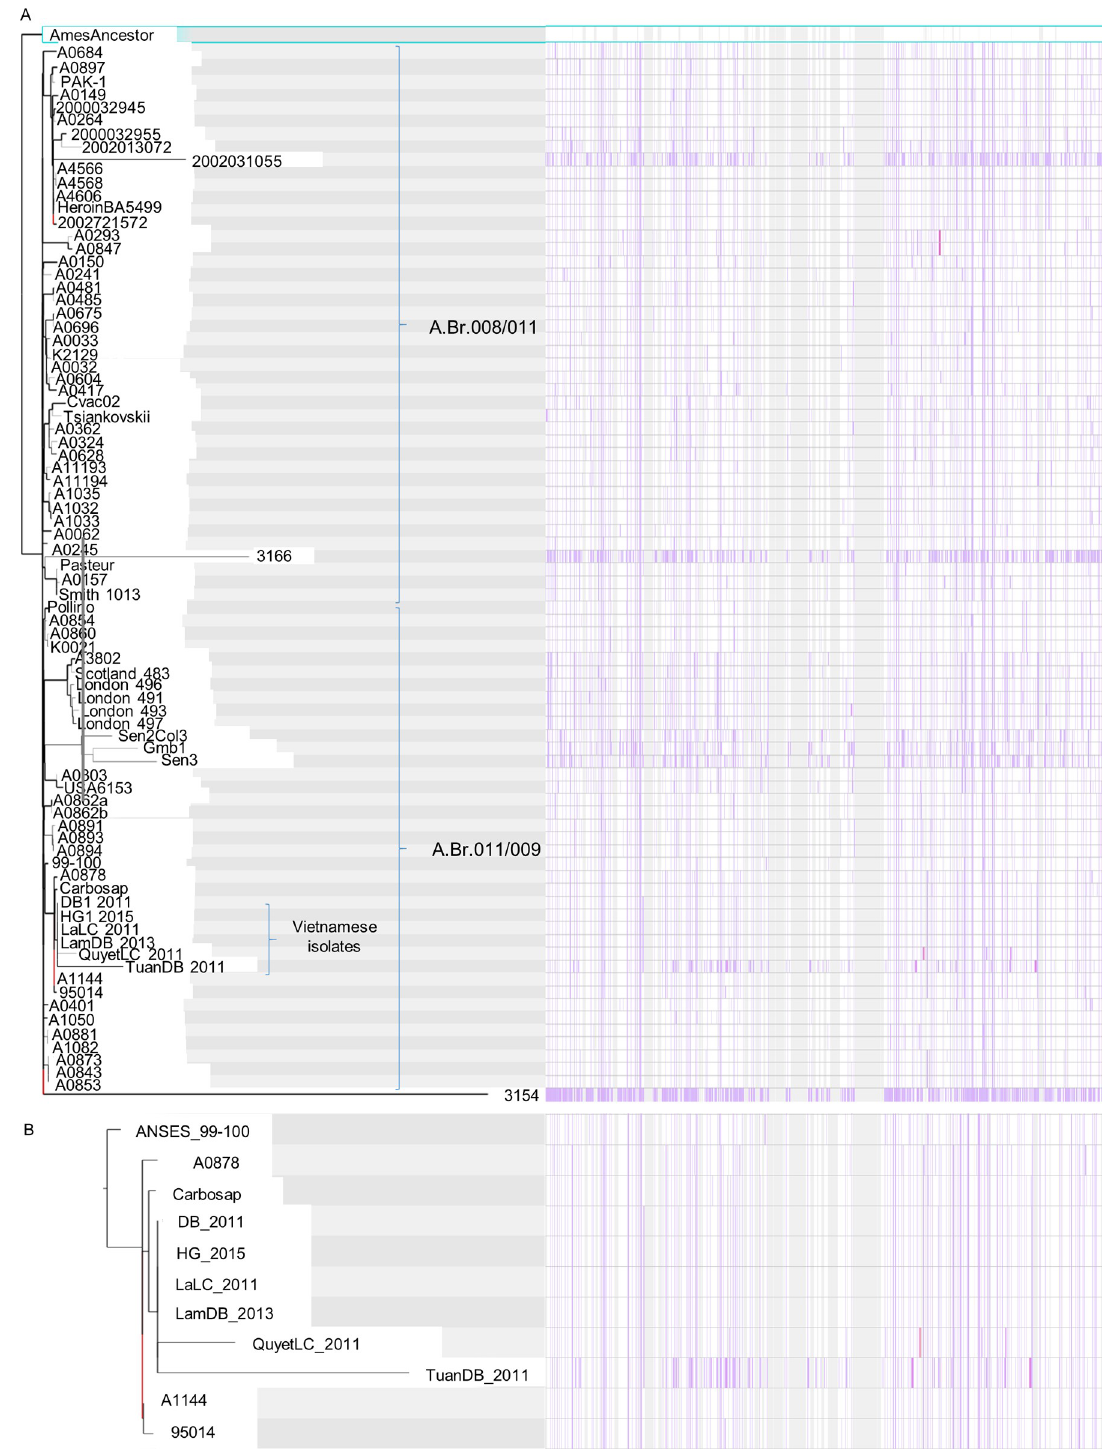
Fig 3. Phylogeny and multiple alignments of B . anthracis strains belonging to A.Br.008/011 and A.Br.011/009 canSNP lineages. A total of 4,976 core genome chromosomal SNPs (S3 Table) from 82 strains were extracted using Parsnp. (A) The phylogenetic tree and SNP heatmap showing SNP density across the genome of each strain of the A.Br.008/011 and A.Br.011/009 canSNP lineages used in the present study. The Ames Ancestor strain was used as a reference and an outgroup. (B) The phylogenetic tree and SNP heatmap of TEA group strains and Vietnamese strains. Screenshots of the phylogenic tree and SNP heatmap were obtained as output by Gingr.